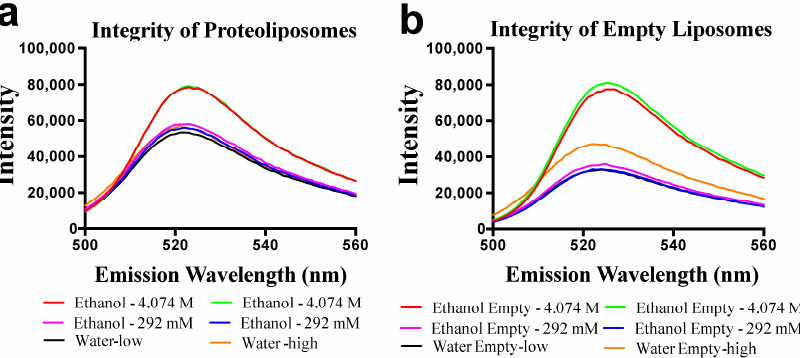
Figure 5. Membrane integrity is maintained in the presence of ethanol and methanol. PLs ( a ) and empty liposomes ( b ) were loaded with 50 mM CF prior to extrusion. Equal volumes of alcohol or water (control) were added to each sample of PLs ( a ) or empty liposomes ( b ). Each sample was then mixed, cuvettes capped off, and emission was monitored between 500 nm and 560 nm. Red, ethanol 4.074 M; magenta, ethanol 292 mM; green, ethanol 4.074 M; blue, ethanol 292 mM; black, water volume corrected to match 292 mM ethanol volumes; yellow, water volume corrected to match 4.074 M ethanol volumes.